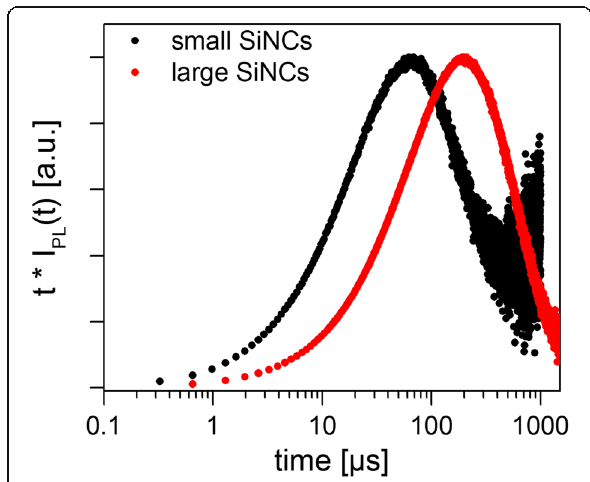
Fig. 4 Normalized PL decay curves multiplied by the decay time (Higashi-Kastner plots) for the small and large SiNC ensembles. The peak positions represent the most dominant decay time, represented by t d in Table 2